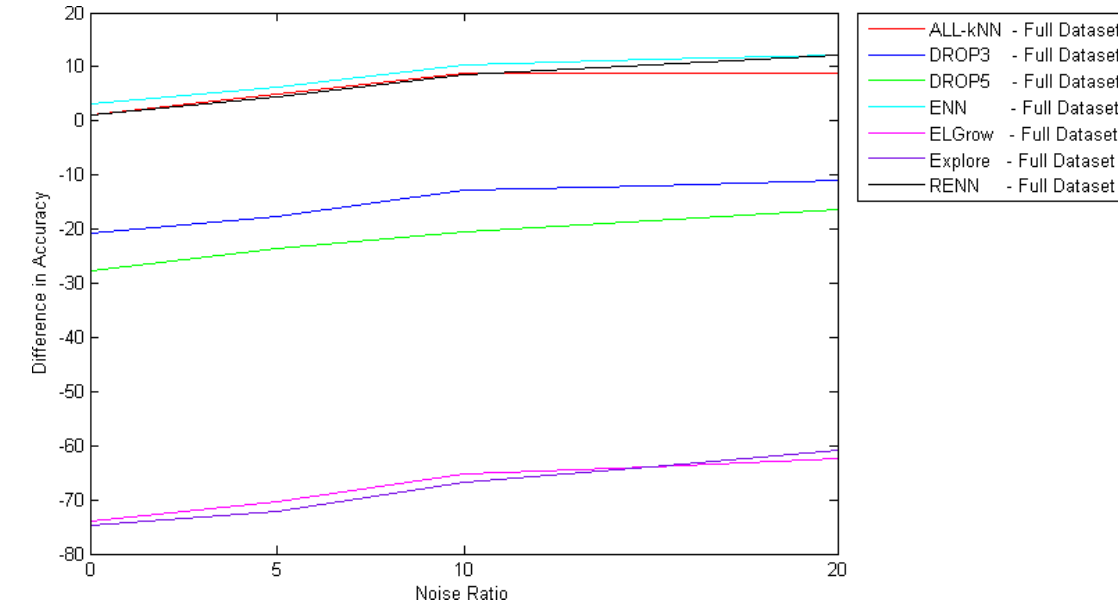
Figure 9: The Difference in accuracy between the full datasets and the reduced datasets with